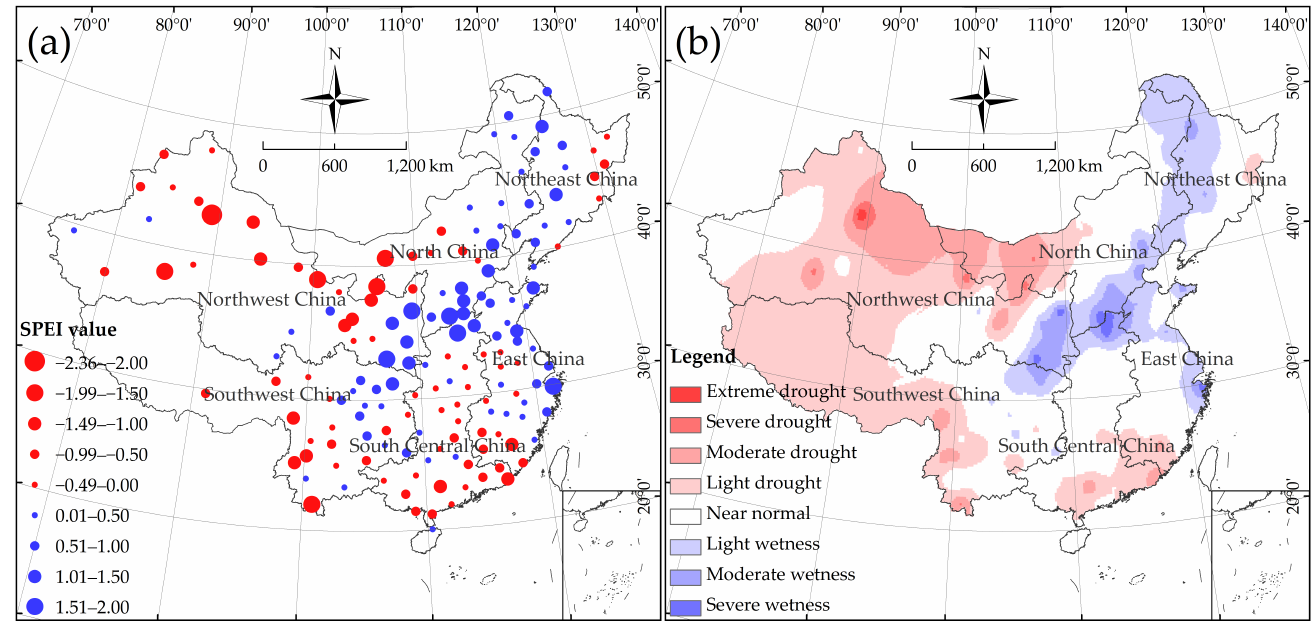
Figure 8. Spatial pattern of drought forecasting for the next year (2022) based on the SARIMA model over China: ( a ) the SPEI value; ( b ) classification of dry and wet status. Red denotes dryness; blue denotes